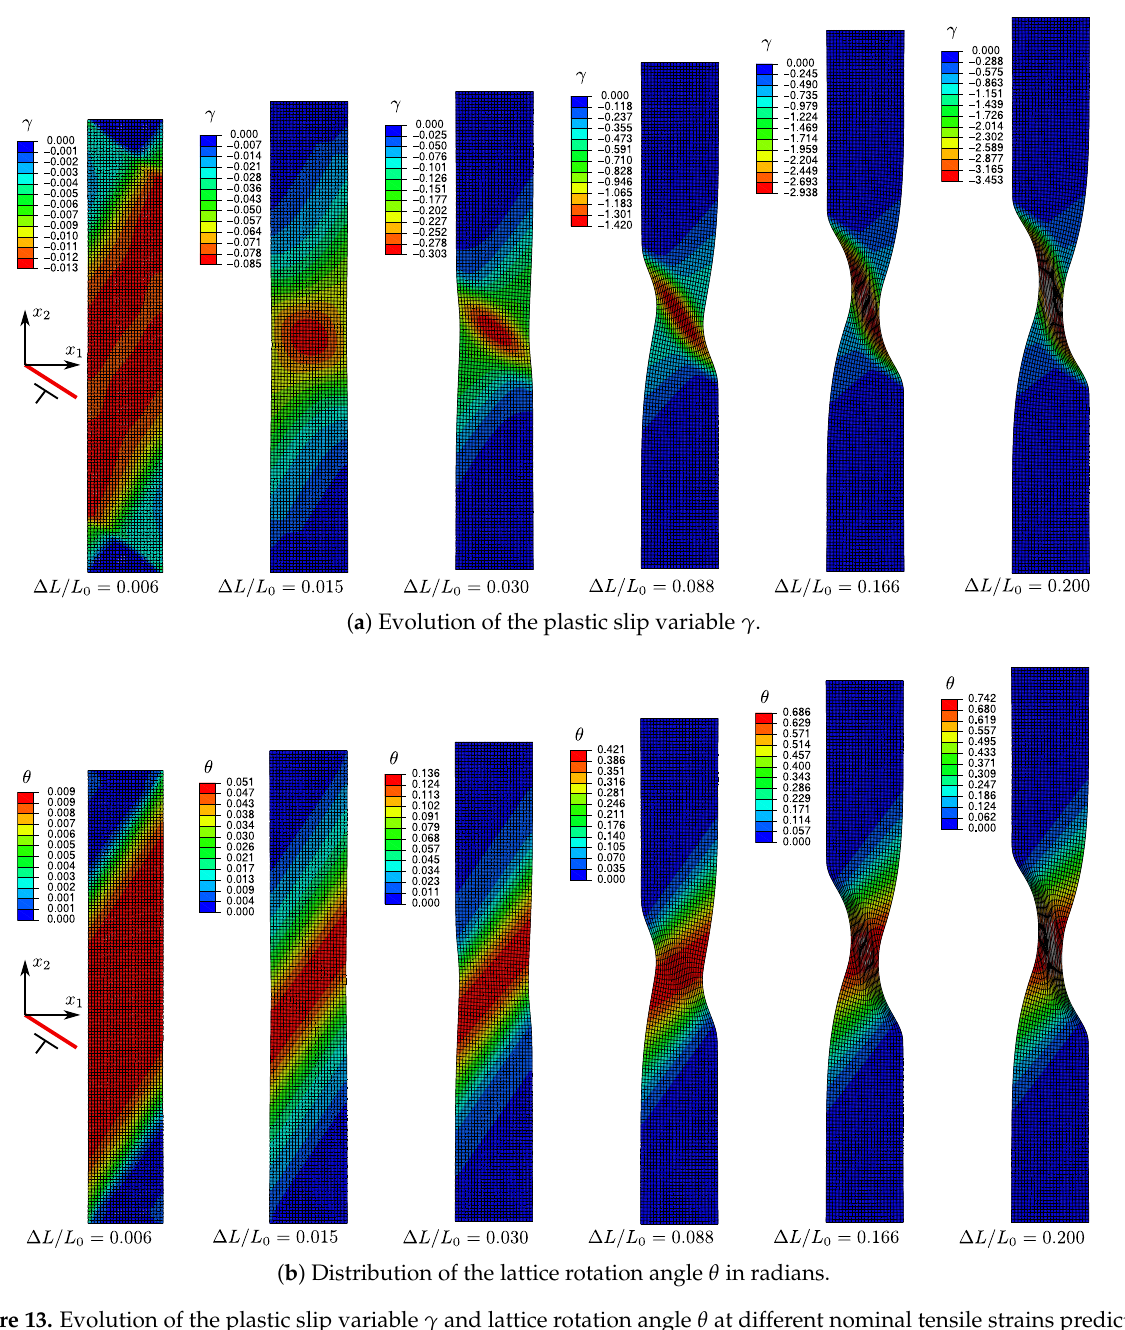
Figure 13. Evolution of the plastic slip variable γ and lattice rotation angle θ at different nominal tensile strains predicted by SGCP including only higher-order energetic effects ( l en / W = 0.25, l dis = 0 )